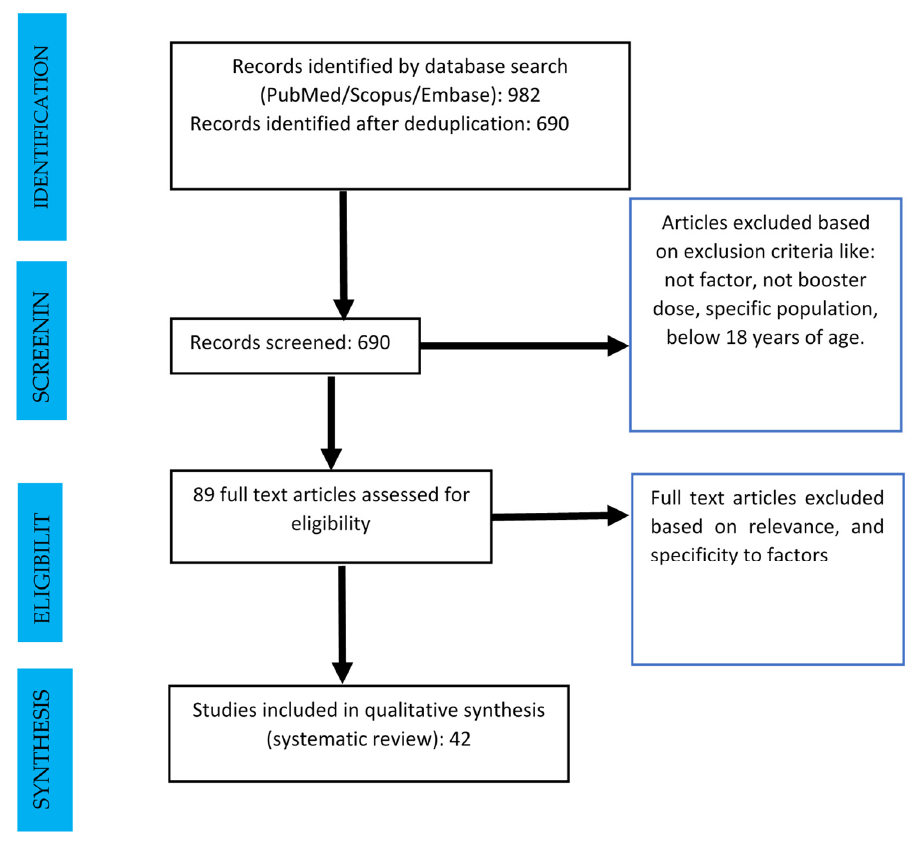
Figure 1. The workflow of the study utilizing the PRISMA guideline.